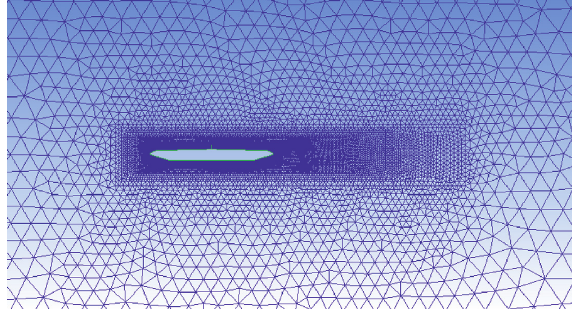
Figure 15: Meshing of the flat steel box girder (local). Table 2: The mean aerodynamic force coefficients of the wind tunnel test and numerical